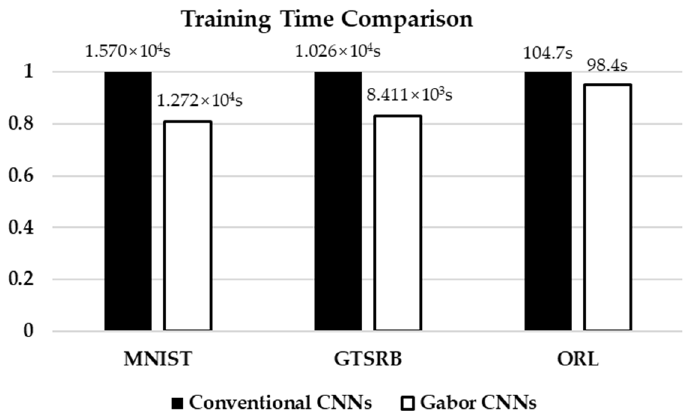
Figure 11. The normalized training time after 200 epochs of the two structures in each dataset.